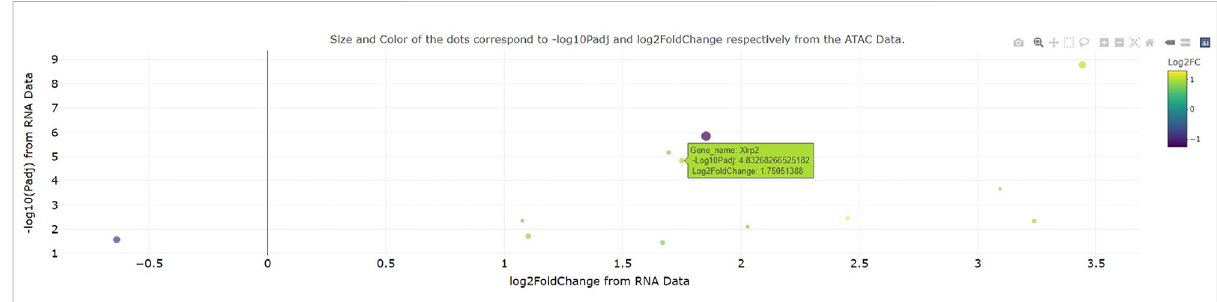
FIGURE 3 Example integrated RNA-seq/ATAC-seq visualization from a collaborator ’ s fi rst time using genomeSidekick. A collaborator recently visualized changeintranscriptionandpromoteraccessibilityatthemurine Xirp2 locusafter3 dayscardiacpressureoverload.Thisgene,alsoupregulatedatthe transcriptional level after angiotensin II treatment, also becomes more accessible with pressure overload, suggesting that the observed increase in transcription is a consequence of increased accessibility. Dot size and color scale indicate ATAC-seq-log10(adjusted p -value) and log2FoldChange, respectively. Example data shown have padj and FDR less than 0.05 in the RNA and ATAC-seq datasets, respectively.